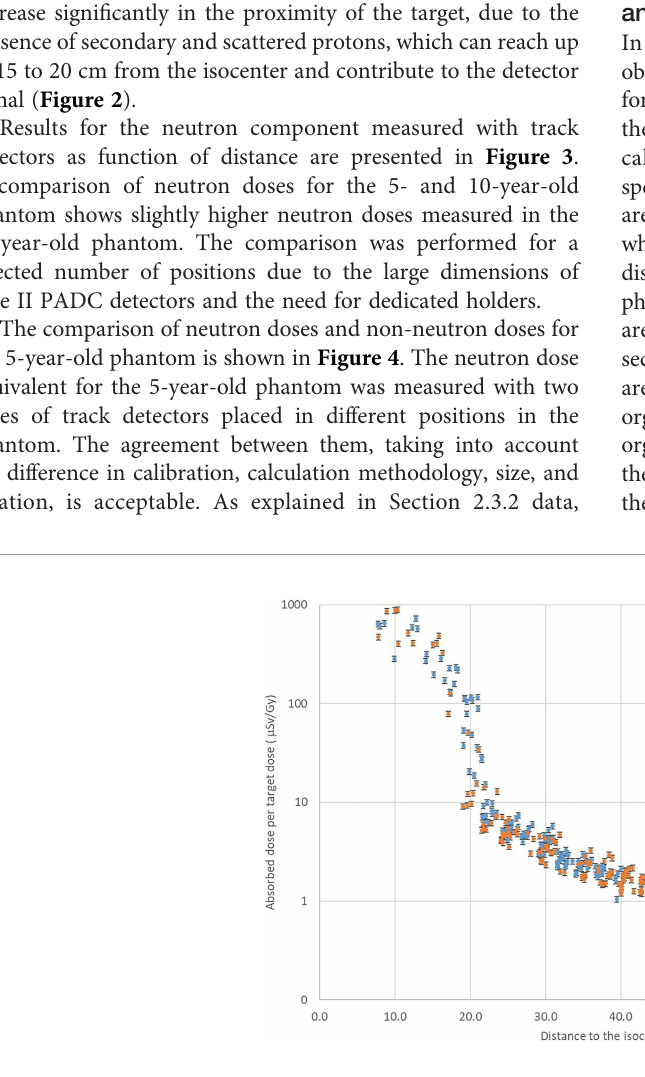
FIGURE 2 | Comparison of non-neutron doses measured with RPL detectors for the 5- and 10-year-old phantom as a function of the distance from the